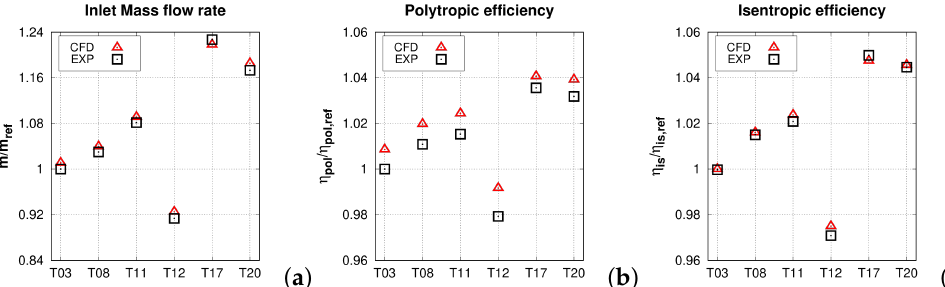
Figure 5. Compressor inlet mass flow rate ( a ) , polytropic efficiency ( b ), and isentropic efficiency ( c ) for the six cases experimentally tested by Ansaldo Energia